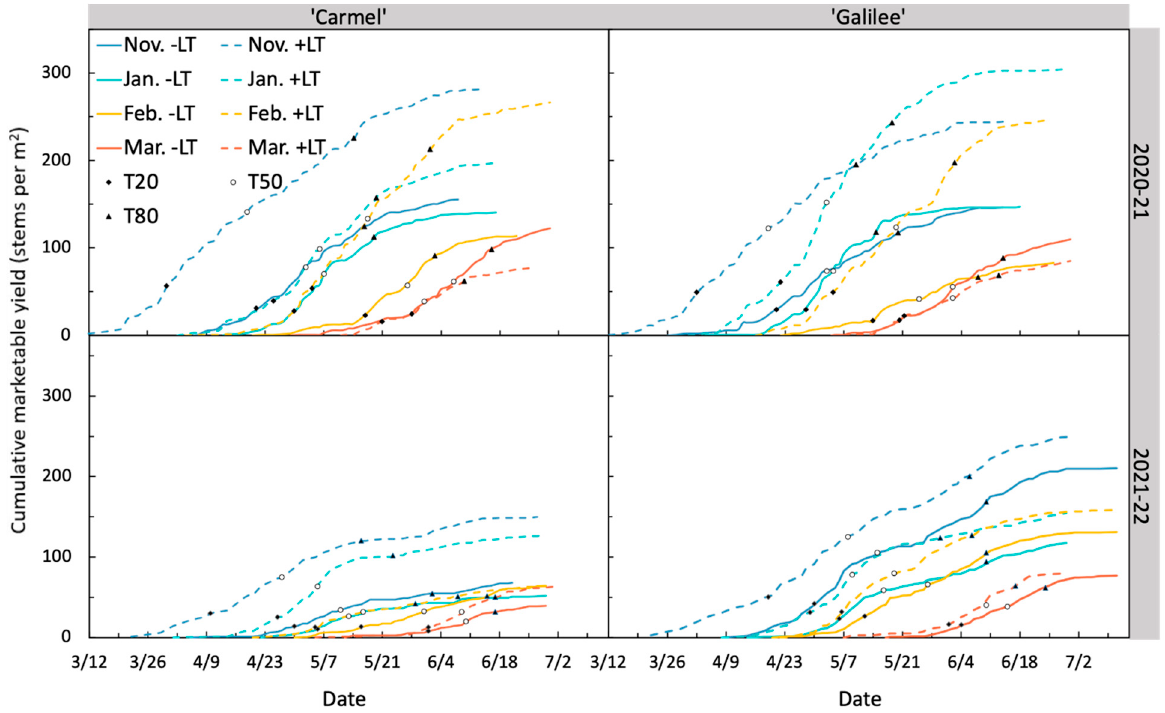
Figure 3. Field cumulative marketable yield of ‘Carmel’ ( left ) and ‘Galilee’ ( right ) anemone in 2020- 21 ( top ) and 2021-22 ( bottom ) in North Logan, UT, by planting date (November—blue; March—red; April—green) that were left uncovered ( − LT − M—solid) or insulated with mulch ( − LT + M—long dashes), a low tunnel (+LT − M—short dashes), or mulch and a low tunnel (+LT + M—dots). T20 (diamonds), T50 (circles), and T80 (triangles) mark when 20, 50, and 80% of the total marketable yield is achieved, respectively.